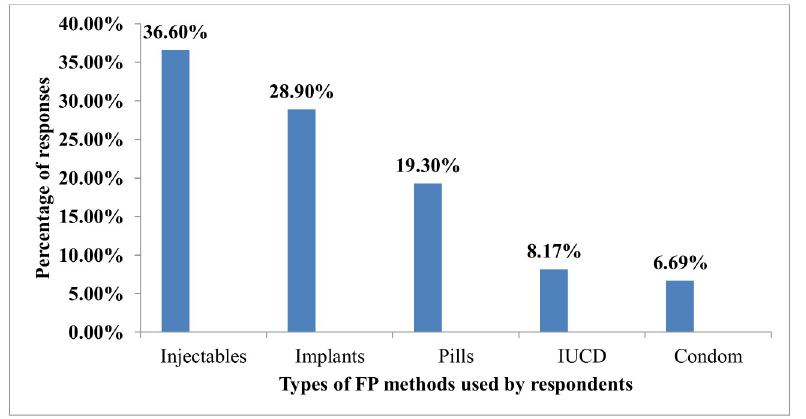
Fig 2. Types of modern PAFP methods utilized from health facilities in Wolaita Sodo,